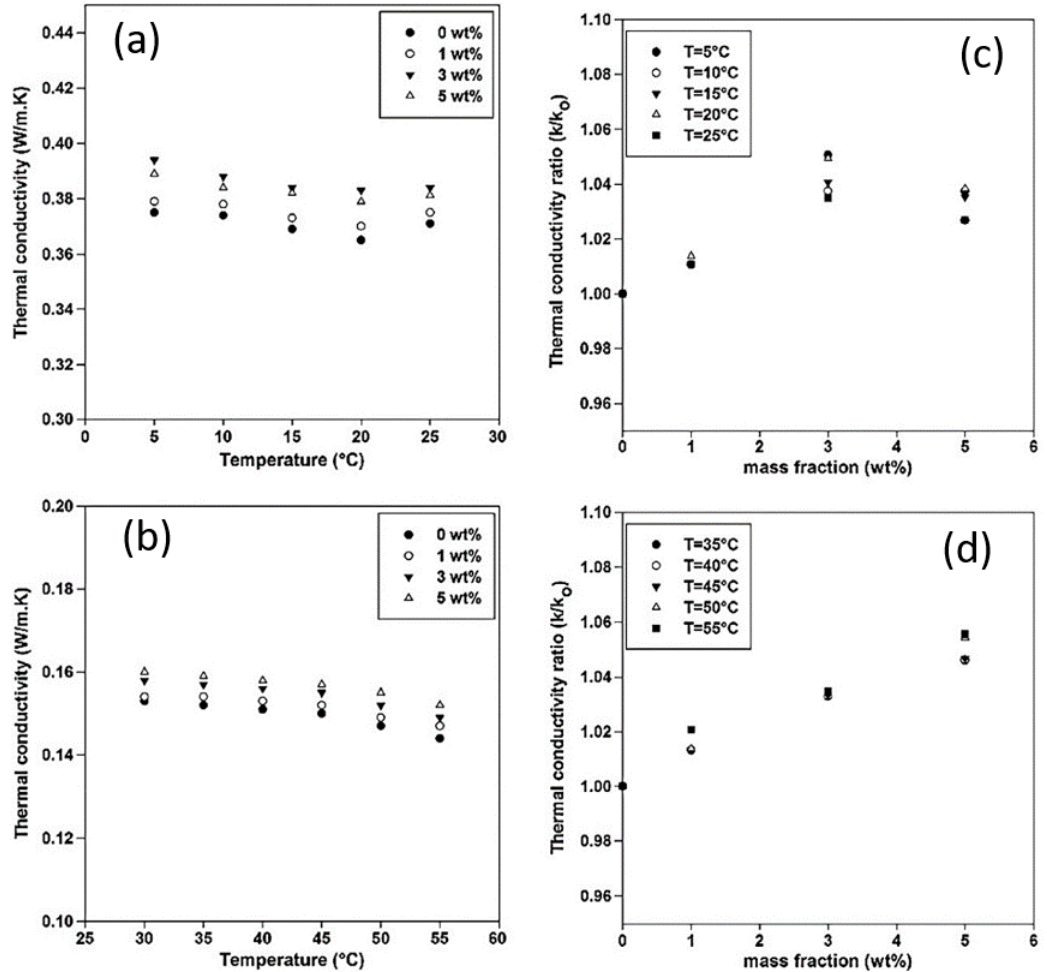
Figure 6. Left: Thermal conductivity of PCM/MPSiO 2 as a function of temperature for carious mass fractions of nanoparticles—( a ) solid phase, ( b ) liquid phase. Right: Thermal conductivity ratio with respect to nanoparticle concentration at different temperatures—( c ) solid phase, ( d ) liquid phase [2].